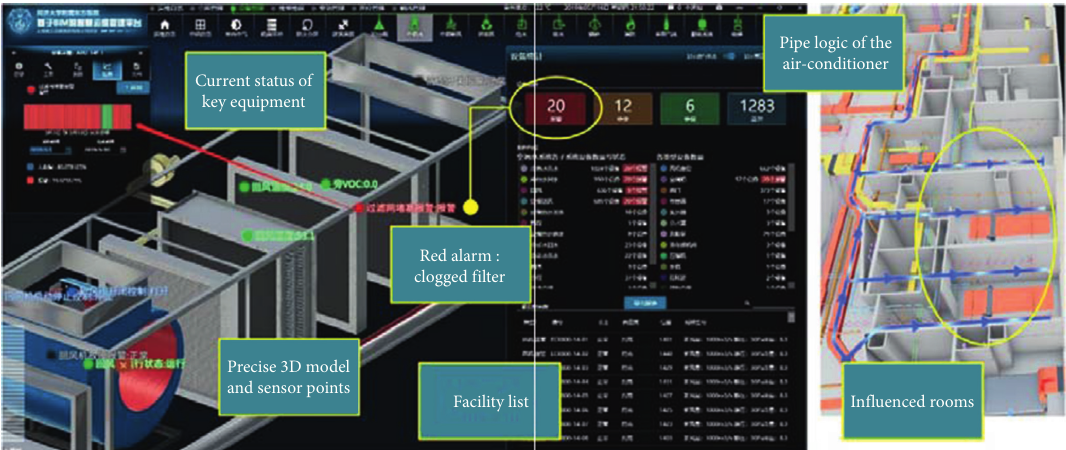
Figure 8: Facility management and connection logics.